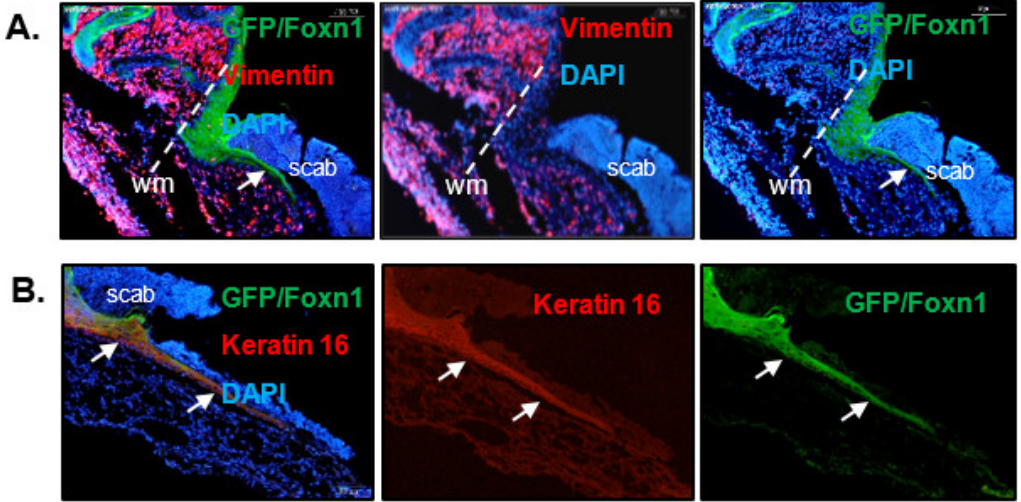
Figure 2. Foxn1 expression in injured skin of Foxn1::eGFP mice at post-wounded day 2 ( A ) and day 3 ( B ). wm—wound margin, arrows indicate leading epithelial tongue.